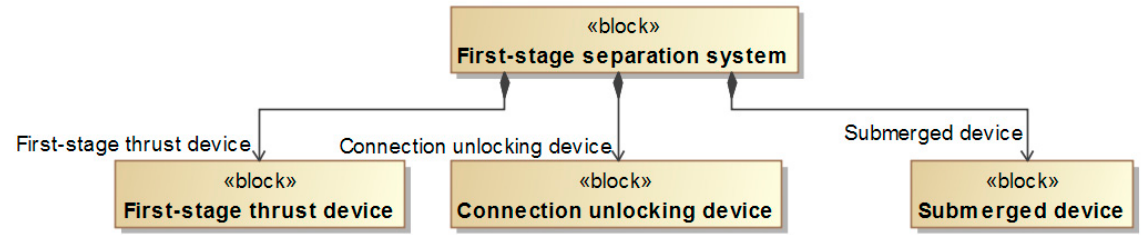
9 of 15 Figure 9. Calculation of submerged thrust.